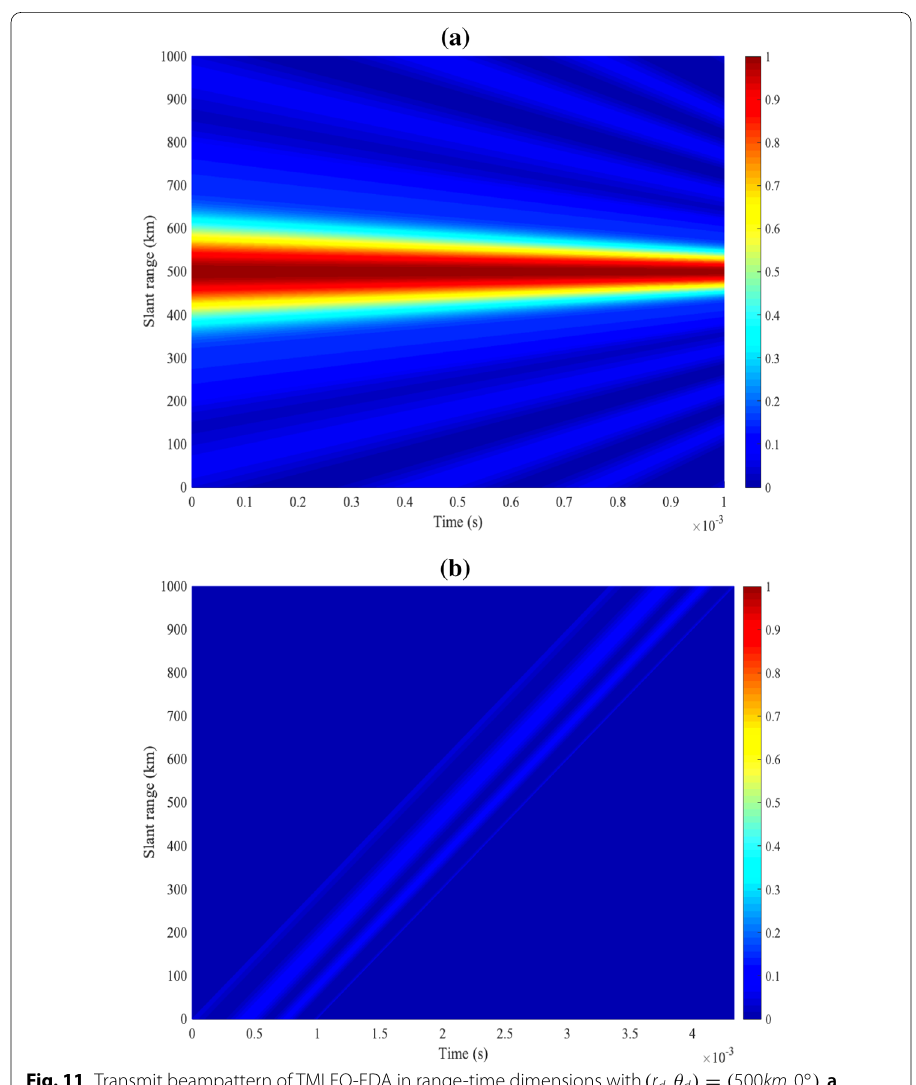
Fig. 11 Transmit beampattern of TMLFO‑FDA in range‑time dimensions with ( r d , θ d ) = ( 500 km ,0 ◦ ) . a Original time‑invariant beampattern. b Corresponding correct beampattern